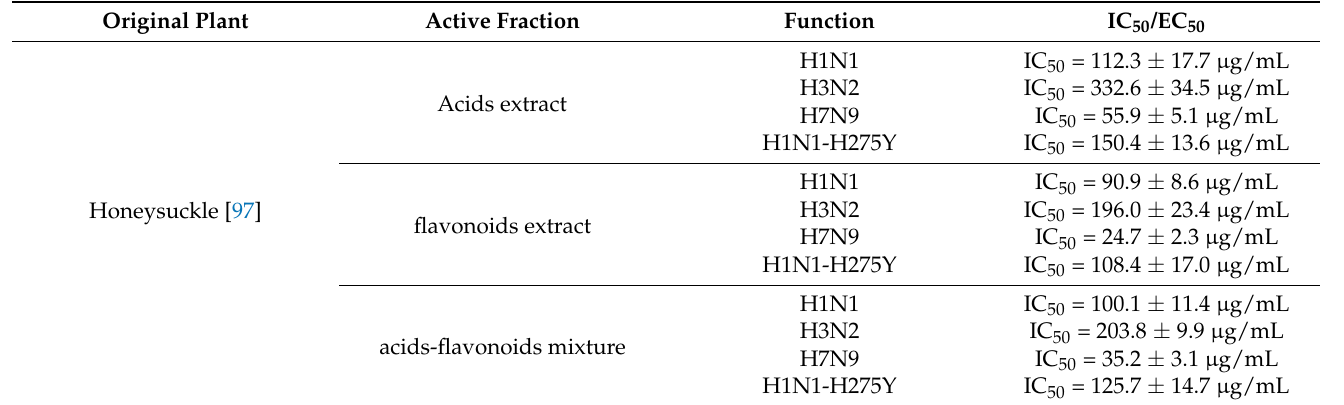
Table 2. List of plant